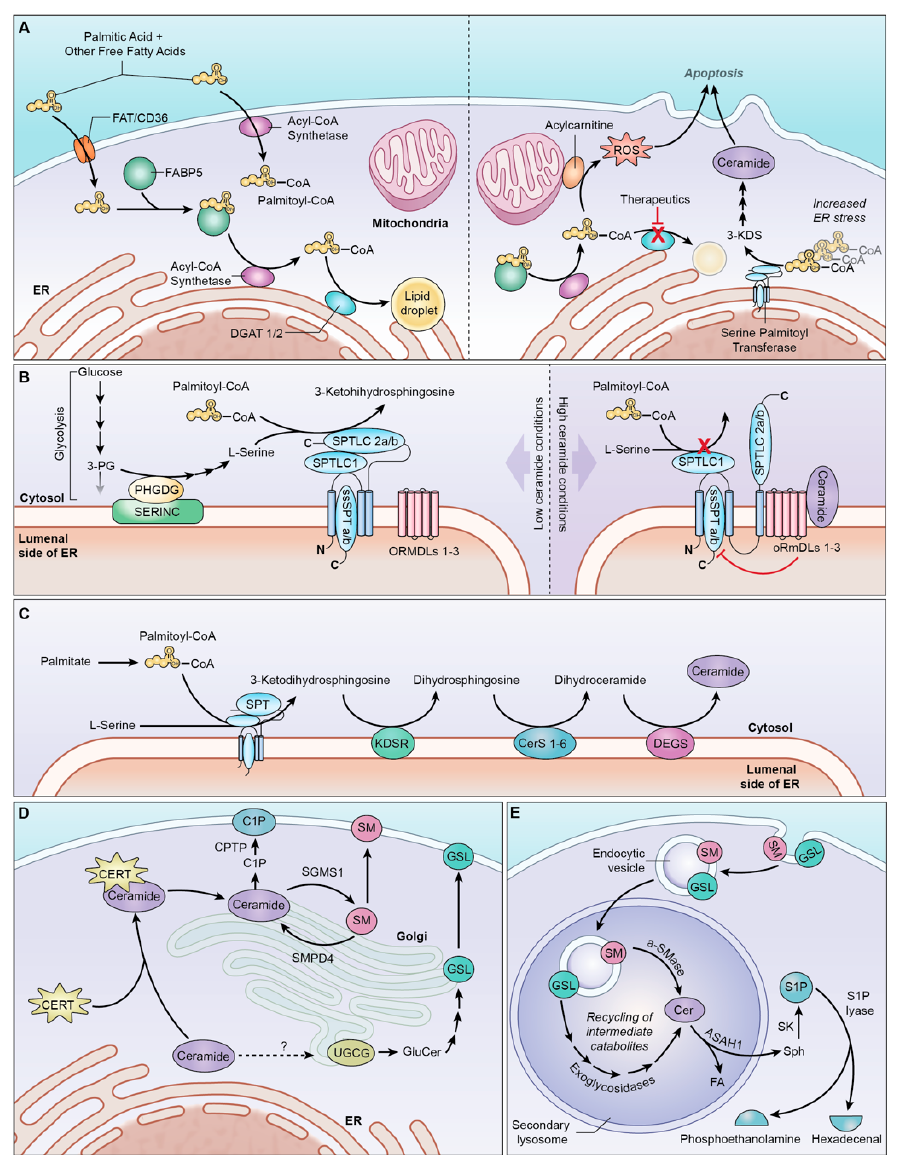
Figure 2. Sphingolipid synthesis and biology. ( A ) FA import and storage in lipid droplets. Interrup- tion of this process can result in FA accumulation in the cytosol, inducing ER stress, ROS production, and eventually apoptosis. ( B ) SPT complex, demonstrating the roles of different subunits. ORMDLs are known to inhibit catalytic activity in high-ceramide conditions. ( C ) De novo ceramide synthesis occurs via four consecutive enzymatic steps in the cytoplasmic leaflet of the ER membrane. ( D ) De novo ceramide can be transported to the Golgi for sphingomyelin, ceramide-1-p, or glycosphingolipid synthesis. These metabolites are then transported to the cell membrane, where they play various which merges with enzyme-containing lysosomes to degrade